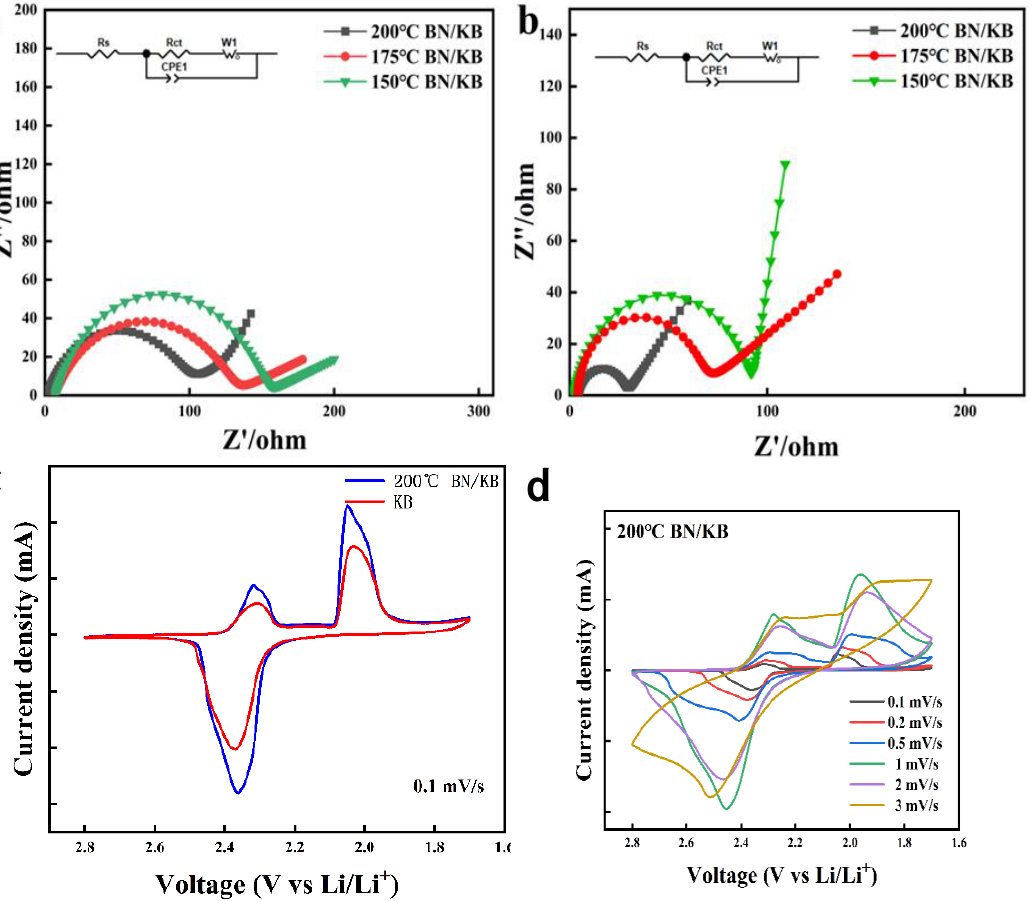
Figure 8. Nyquist plots of BN/KB cells before and after cycling at 200 °C, 175 °C, and 150 °C and the corresponding equivalent circuits ( a , b ). CV of BN/KB vs. KB ( c ) and CVs of BN/KB at 200 °C at different sweep speeds ( d ).